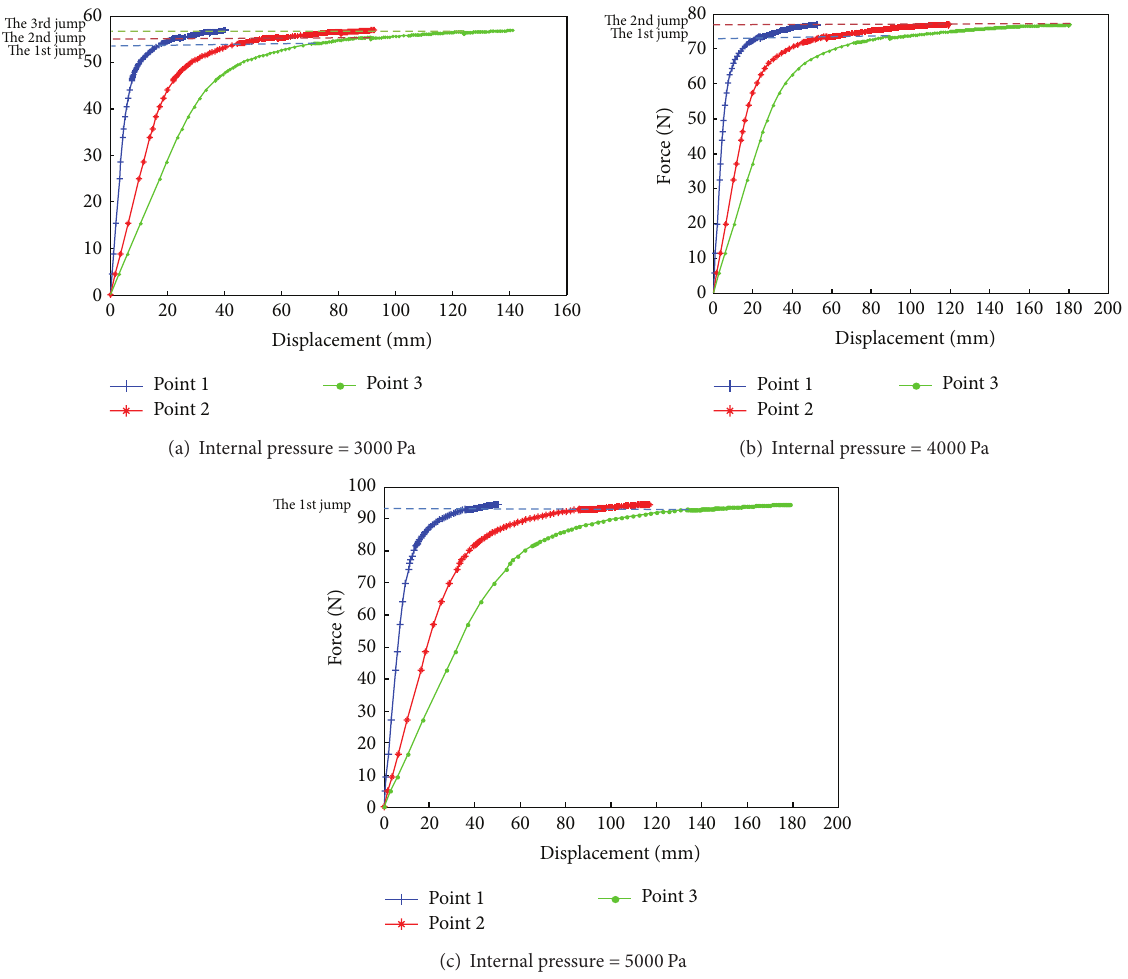
Figure 9: Load-deflection behavior of the ETFE inflatable beam adopting shell model.